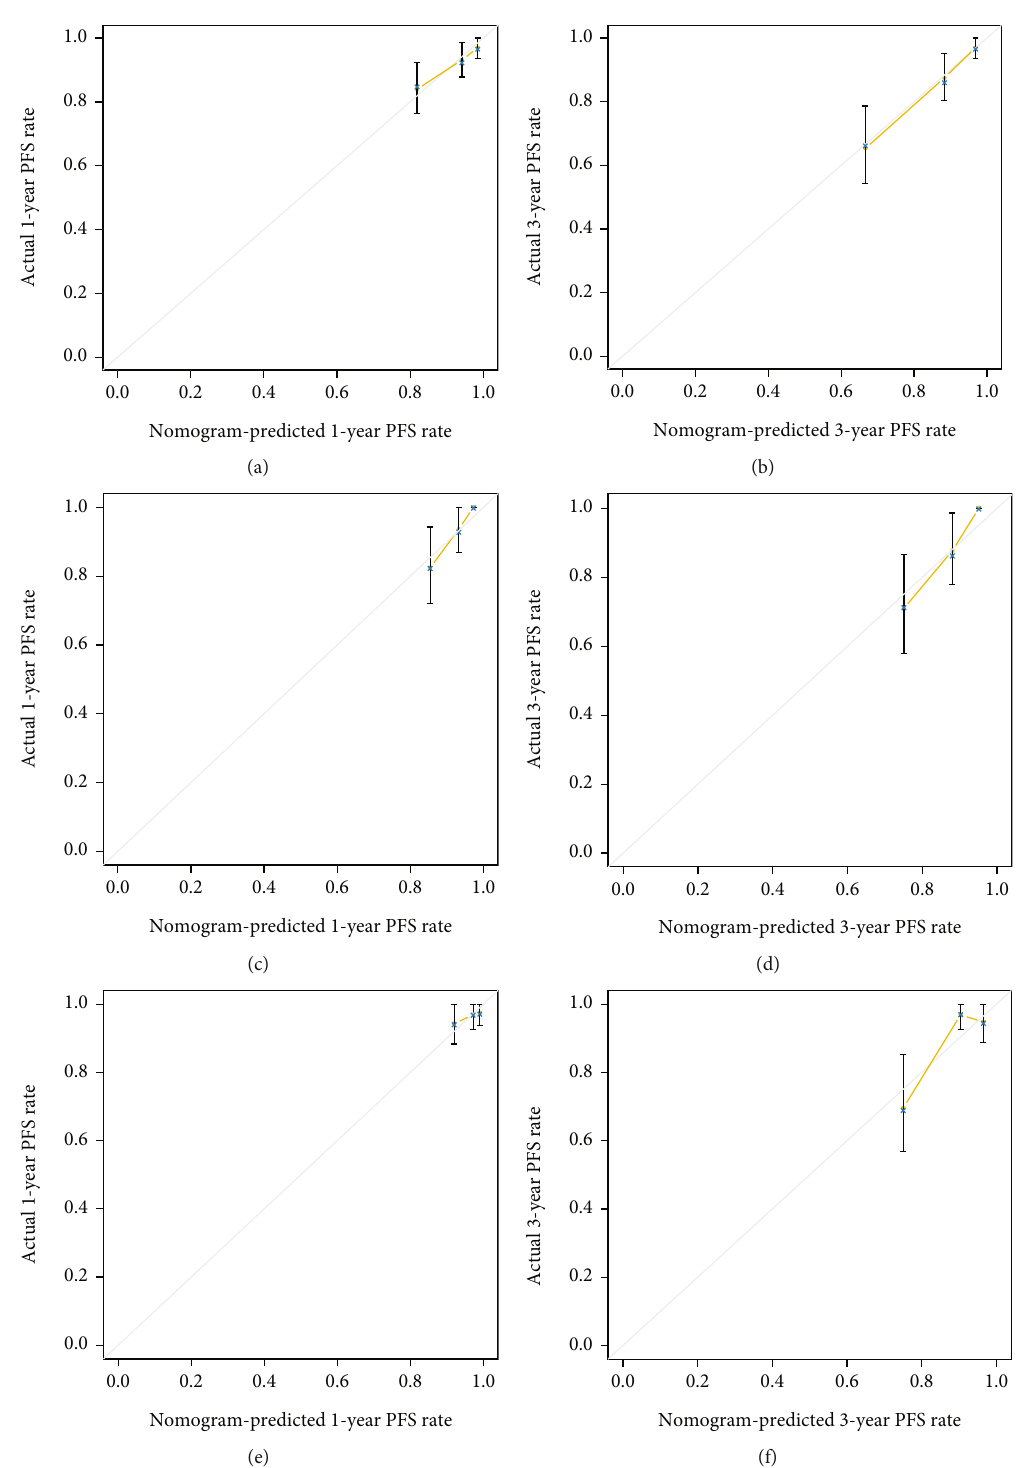
Figure 2: Calibration curves of the nomogram. The observed PFS is shown compared with the nomogram at (a) 1 year and (b) 3 years in the training cohort, at (c) 1 year and (d) 3 years in the internal validation cohort, and at (e) 1 year and (f) 3 years in the external validation cohort. The calibration curves depict the calibration of the nomogram in terms of the agreement between the predicted risk of RAP and the observed RAP outcomes. The 45-degree gray line represents a perfect prediction, and the yellow solid lines represent the predictive performance of the nomogram. The distance between the yellow solid line and the ideal line represents the superior predictive accuracy of the nomogram. Abbreviations: PFS: pneumonia-free survival; RAP: radiation-associated aspiration